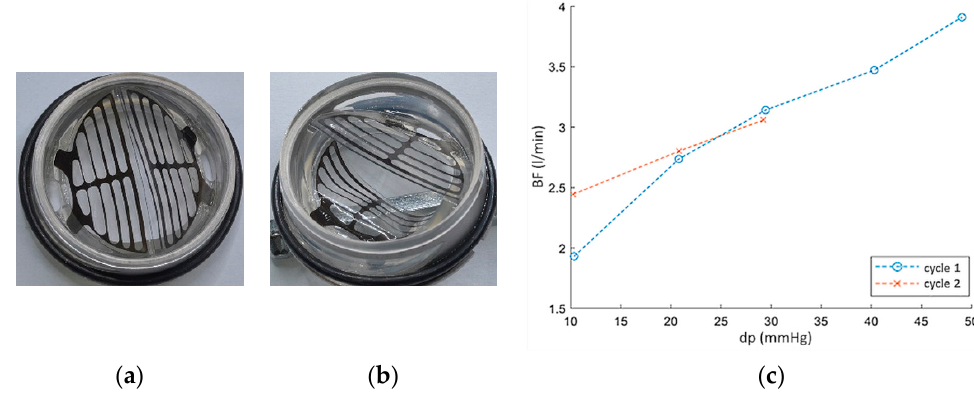
Figure 15. ZWP-Ti valve: ( a ) leaflet after manufacturing, ( b ) leaflets break and open backwards in the direction of flow for dp = 45 mmHg, ( c )the pressure at which the leaflets of the valve break for first and second cycle of work.